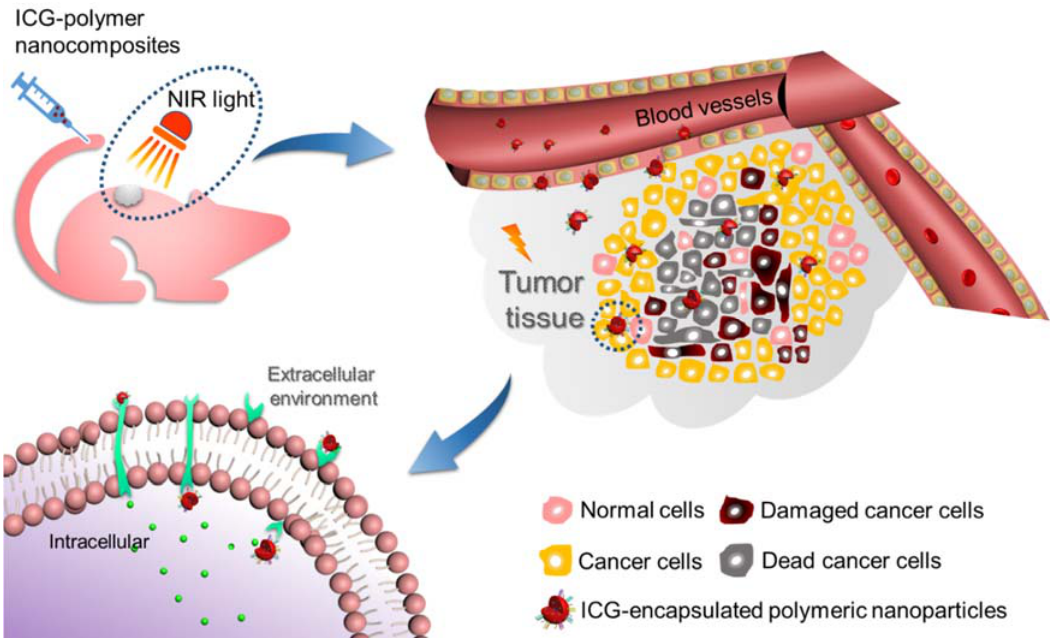
Figure 7. Schematic illustration showing the active photo ‐ induced therapeutic strategy using ICG ‐ encapsulated polymeric nanoparticles that have been used in ablating the cancer